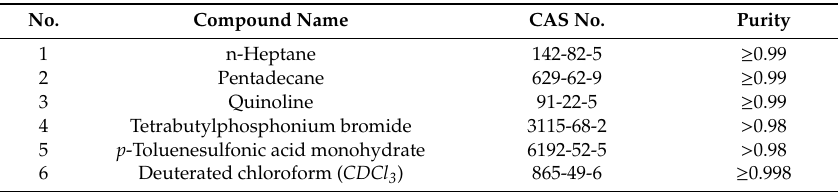
Table 2. List of purchased chemicals used in this